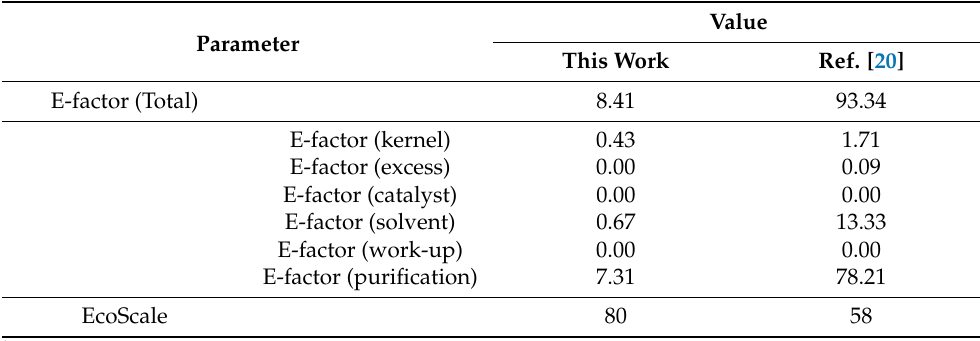
Table 1. E-factor profile and EcoScale scores for the synthesis of 1,3-bis(3-carboxypropyl)imidazole ( bcpim ) 1 .